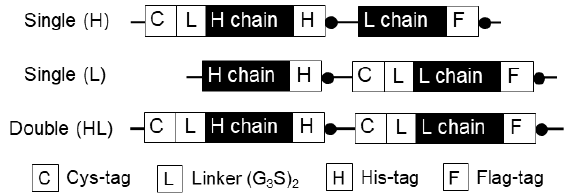
Figure 2. Schematic representations of Q-body expression genes with different fluorescent dye-binding sites.